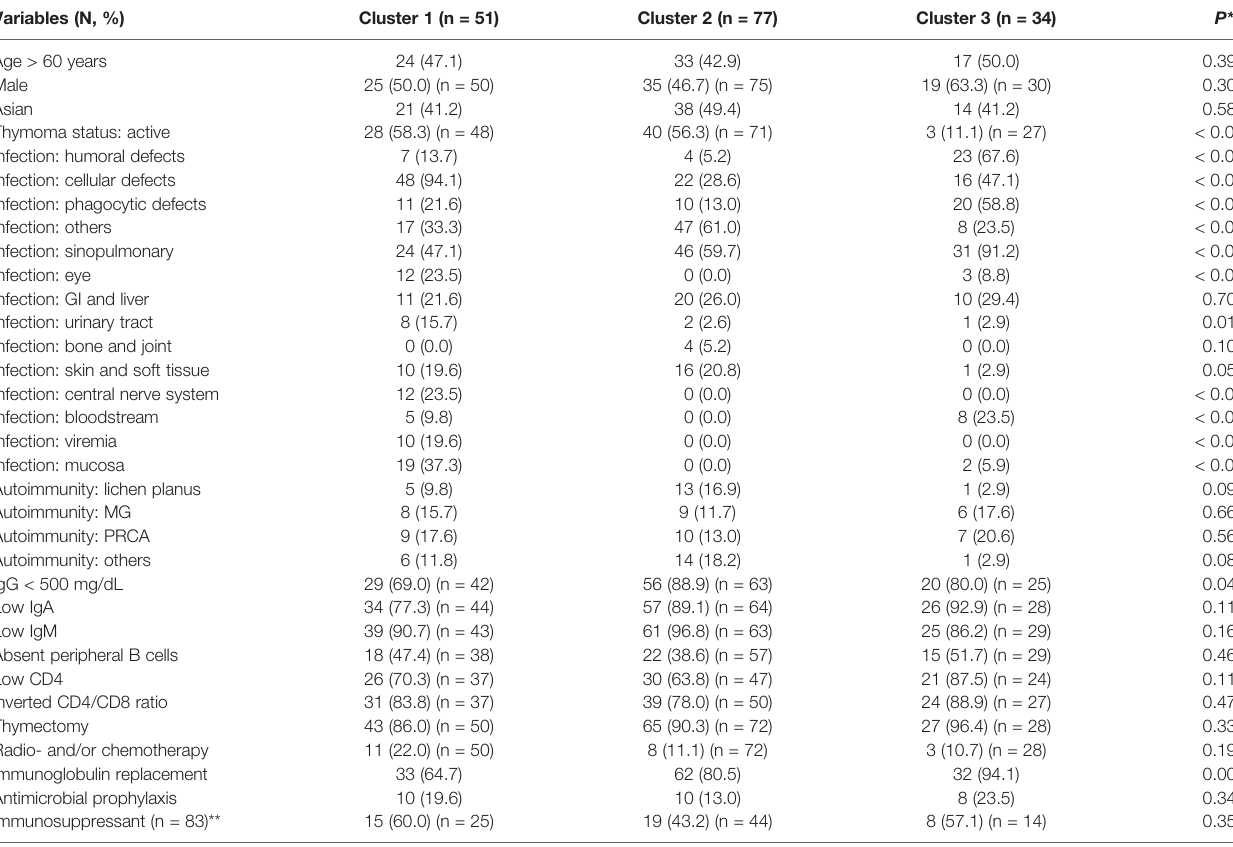
TABLE 3 | Comparison of clinical characteristics among the three subgroups of patients with Good syndrome. Variables (N,